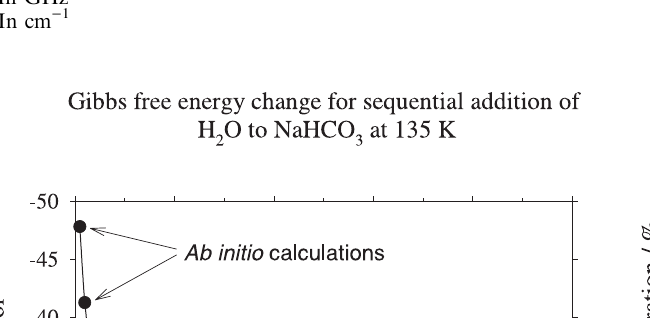
Table 2. Calculated molecular parameters at the B3LYP/6-311+G(2d,p) level of theory for NaHCO NaHCO Æ 2H O. The geometries and dipole moments are contained in Fig. 3 3 2 Species